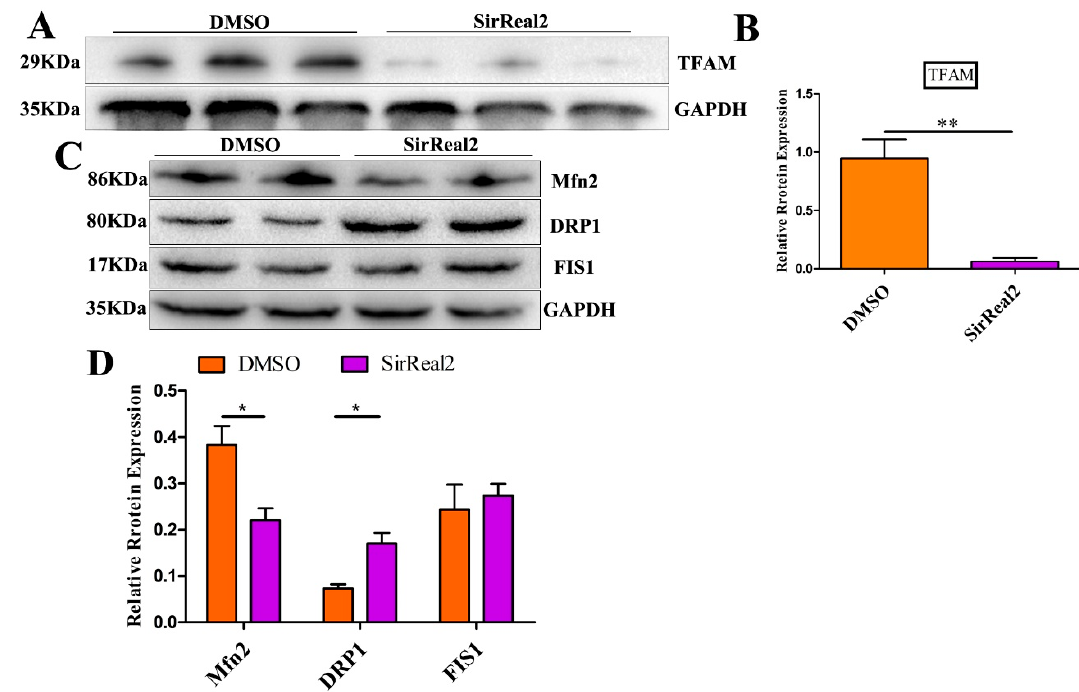
Figure 6. SIRT2 regulated mitochondrial biogenesis and dynamics. ( A ) Western blot analysis revealed reduced mitochondrial transcription factor 1 (TFAM) expression in SirReal2-exposed (5 μ M) oocytes.